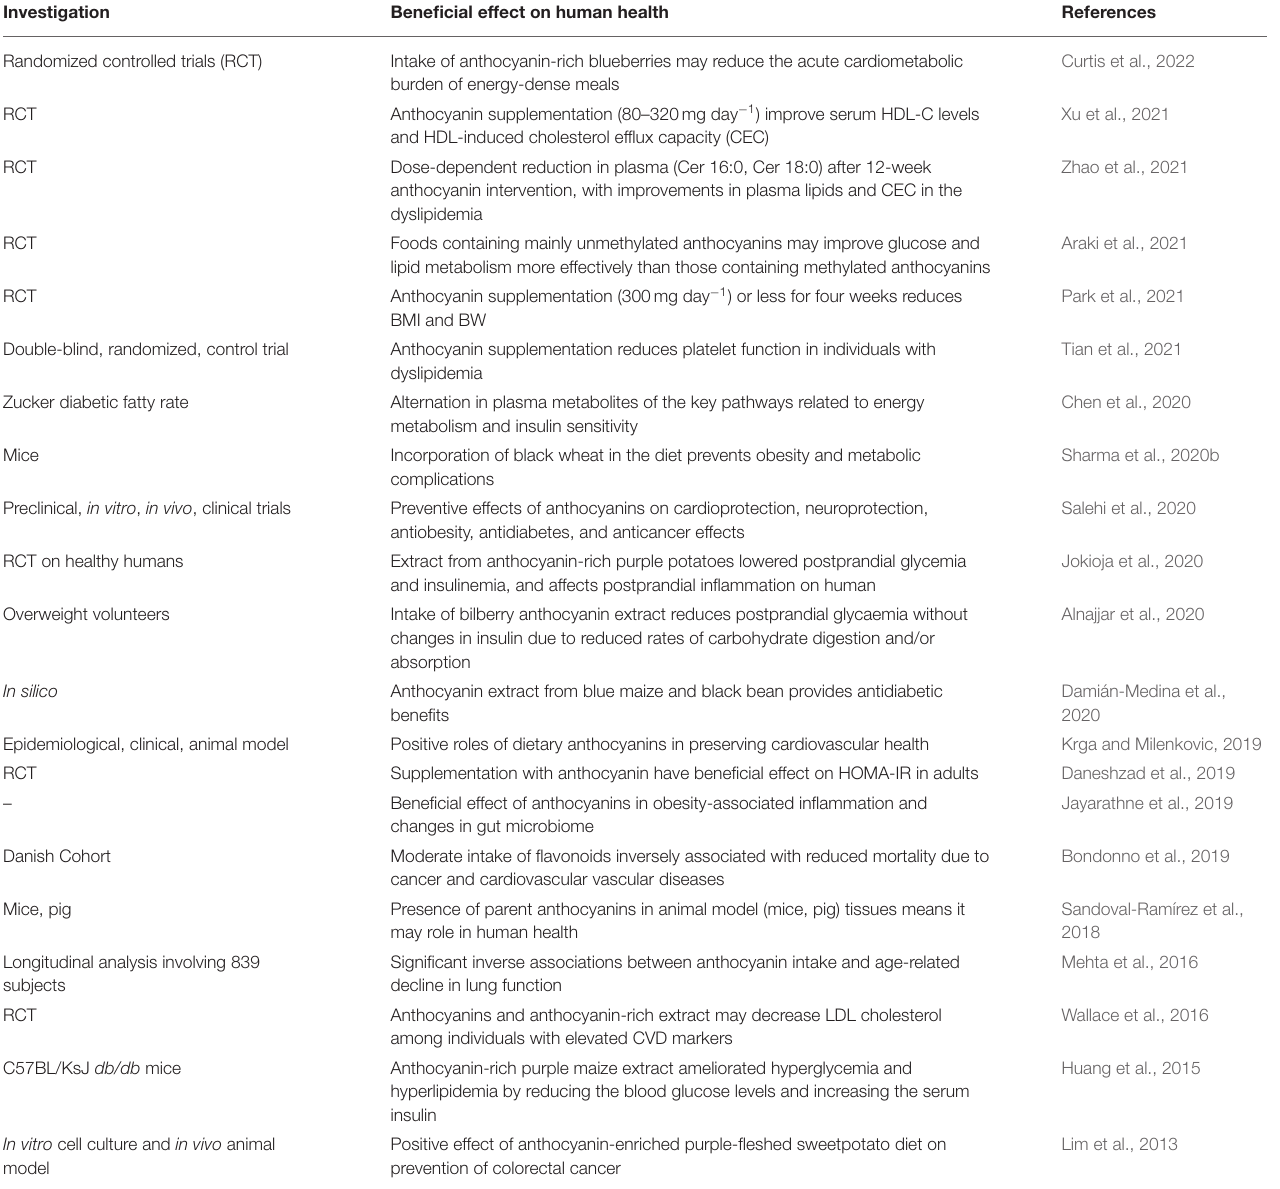
TABLE 1 | Description of health promoting properties of anthocyanin-rich food on humans.